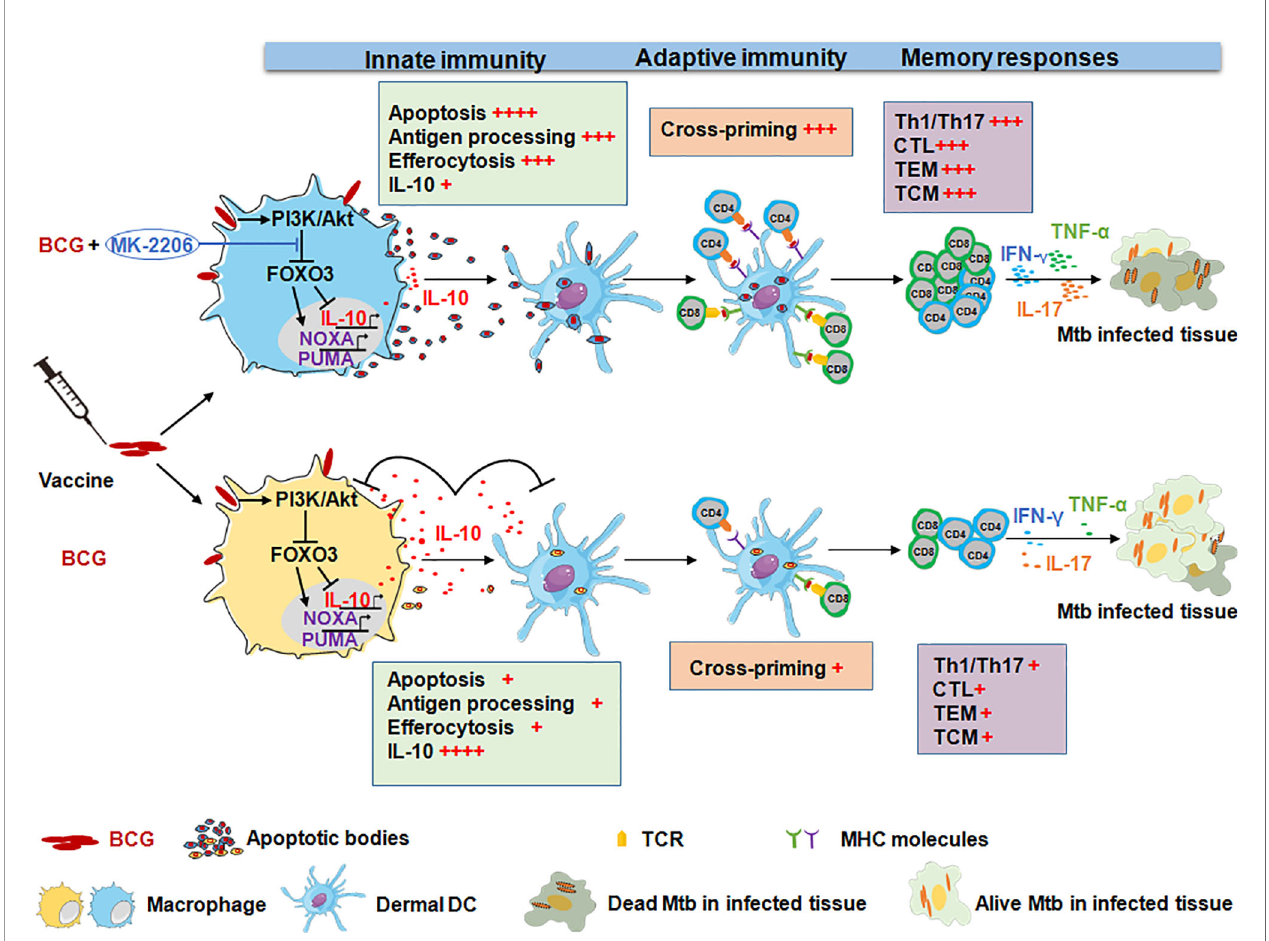
FIGURE 9 | Administration of the Akt kinase inhibitor MK-2206 post BCG vaccination confers higher protection against aerogenic infection. Immunization with BCG induces IL-10 production and also promotes macrophage survival by activating the PI3K/Akt signaling pathway. The activated Akt translocate into the nucleus and phosphorylates FOXO3. The phosphorylation of FOXO3 results in cytoplasmic accumulation and its subsequent degradation. This subsequently results in suppression of Th1 immune response and host antimicrobial pathways, which favors bacterial intracellular replication. In contrast, inhibition of BCG-mediated Akt activation by MK-2206 subsequently results in FOXO3 activation which triggers apoptosis and reduces IL-10 secretion. This eventually results in disruption of growth niche for intracellular replication of BCG, promotes recruitment of APCs and efferocytosis, an important source of antigen presentation. Finally, this leads to optimal induction of antigen speci fi c T cells and the generation of higher memory T cell response that translates into better protection against challenge with Mtb in mice and guinea